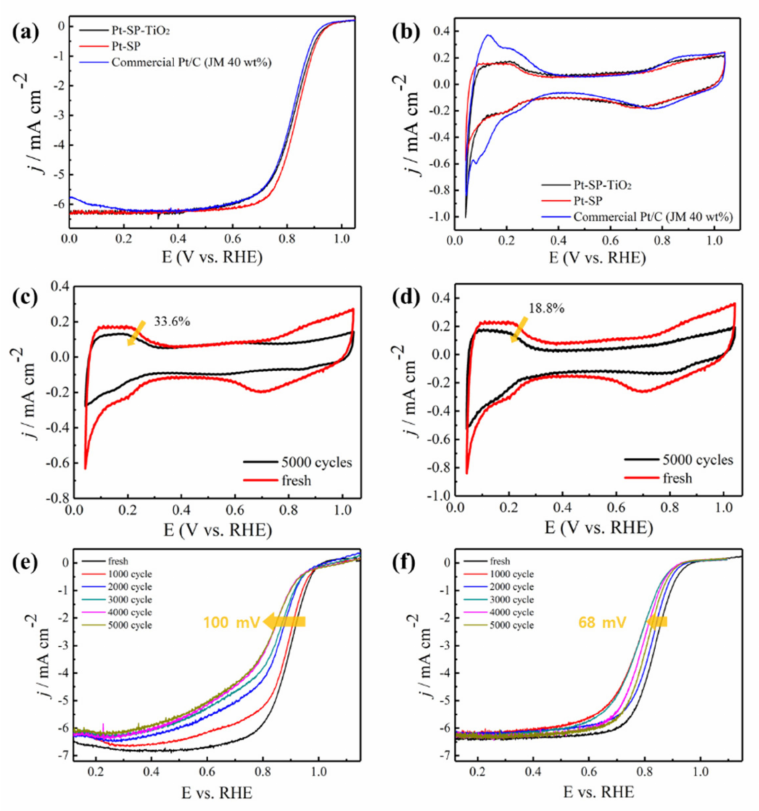
Figure 6. ( a ) ORR activity and ( b ) CV curves of Pt-SP, Pt-TiO 2 -SP, and commercial Pt/C catalysts. Comparison of the electrocatalytic activity and durability, respectively, of Pt/C ( c , e ) and Pt-TiO 2 -SP ( d , f ) before cycling (fresh) and after 5000